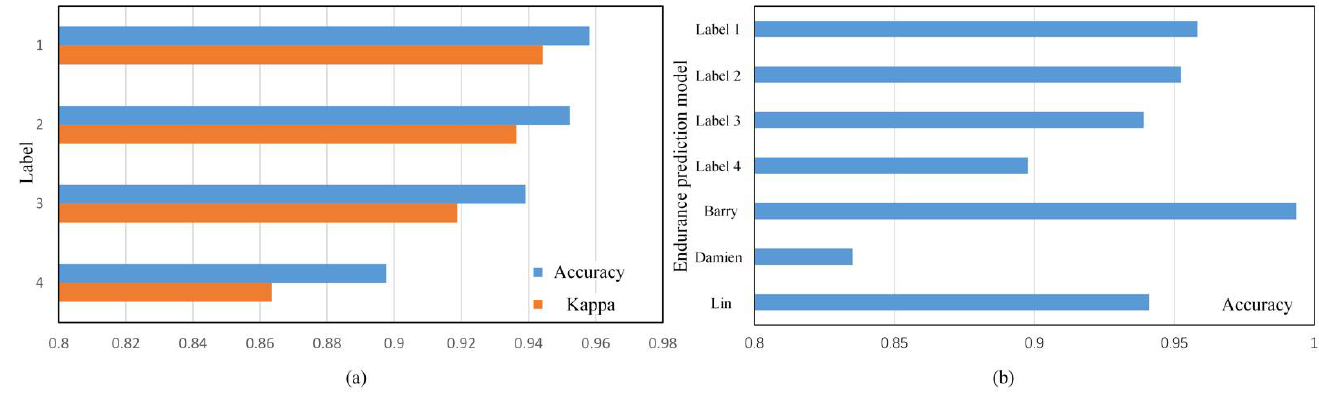
Figure 5. ( a ) Comparison of model accuracy and Kappa coefficient of different labels; ( b ) Comparison of the accuracy of models in other studies.